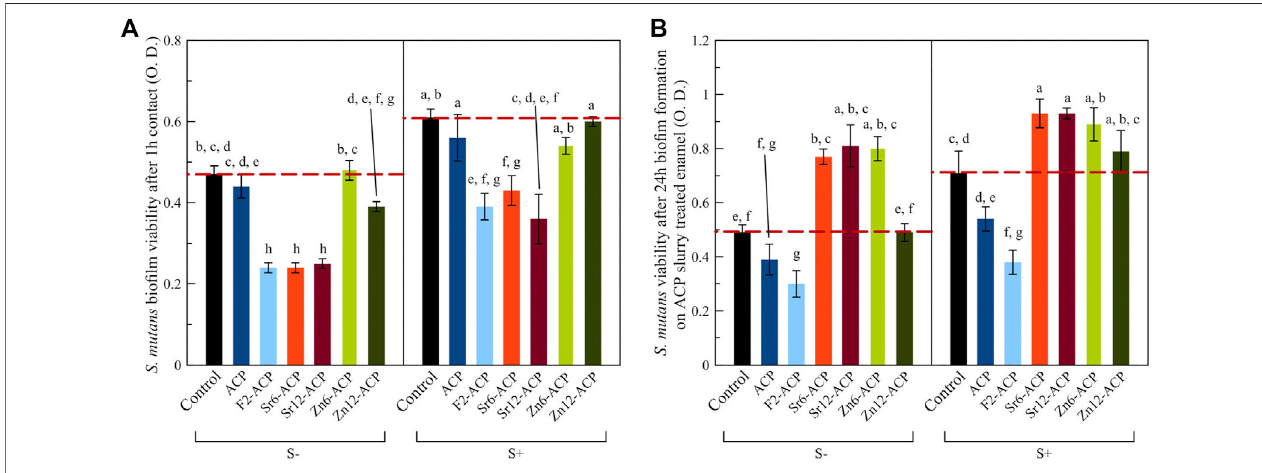
FIGURE 2 | Development of S. Mutans bio fi lm as optical density (O. D.) (A) after treatment with ACP materials or (B) onto enamel remineralized with